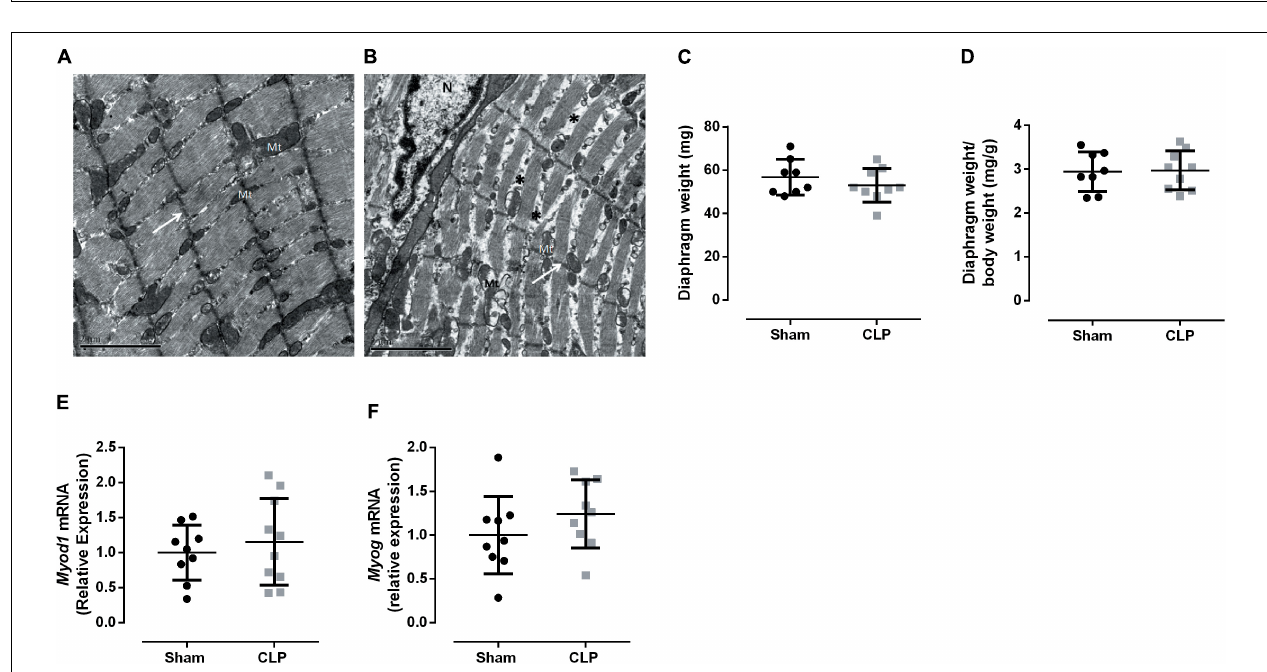
FIGURE 1 | Sepsis clinical score and mortality. Animal survival rate (A) . The percentage compares the total live animal numbers at the beginning (0 h) and end of the experiment (120 h). Sepsis score time evolution (B) . The following variables evaluated the severity of sepsis: piloerection, alterations in gait, lethargy, alterations in respiratory rate, lacrimation, loss of grip strength, decreased body tone, respiratory difficulty after manipulation, lack of exploratory behavior, and body temperature alterations if present animal received 1 point. The sum of the total score reflected the severity of sepsis. Score 2–3 denotes mild sepsis, 4–7 moderated sepsis, 8–10 severe sepsis. Values under the x -axis time point represent the live animal number in each group, gray numbers represent CLP total animals, and black numbers represent the sham group. Black dots represent sham animals caused by surgical stress ( n = 12), and gray squares represent CLP – cecal ligation puncture technique ( n = 19 at 0 h and n = 10 at 120 h). Values expressed as mean ± SD, * p = 0.0007 chi-square, and ** p = 0.0001 unpaired t -test compared with sham mice.